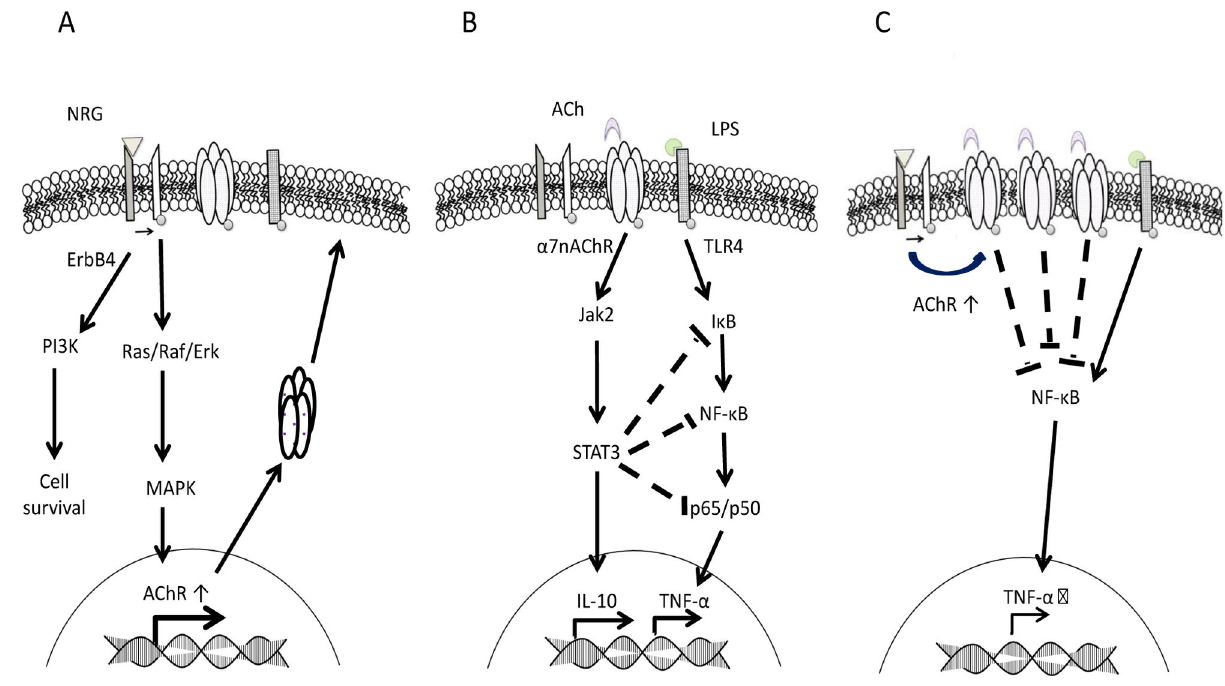
Figure 5. Proposed mechanism of NRGs neuroprotective action during inflammation. Here we propose a model where in NRG amplifies the cholinergic anti-inflammatory pathway mediated by ACh and α7 nAChR during an inflammatory response. In panel A, we describe the possible signaling pathway responsible for the increased expression of α7nAChRs observed in microglia when treated with NRG. NRG signaling through ErbB4 activates Ras/Raf/ERK of the MAPK pathway which leads to cell survival, and in muscle has been shown to activate the N-box response elements associated with the transcription of AChRs. Also of importance to NRGs neuroprotective function is the activation of the p85 subunit of PI3K pathway, its downstream effector PKB/Akt, and Jak/STAT pathways [16,51,52] (not shown); signaling mechanisms also involved in cell survival. In panel B, we describe the well established cholinergic anti-inflammatory pathway [modified from 38]. In response to inflammatory mediators, activation of the α7nAChR by its ligand ACh inhibits the synthesis of TNF-α by preventing the nuclear translocation of the p65 subunit of NF-κB. In addition, the activation of Jak2/STAT3 supports the synthesis of anti-inflammatory cytokine IL-10 and further attenuates TNF-α production by STAT3 action on IκK, NF-κB and p65. In panel C, we propose that in LPS-challenged microglia NRG acting in concert with ACh leads to increased reduction of TNF-α by inducing increased expression of α7nAChR and as such amplifying the cholinergic anti-inflammatory pathway by providing more receptors for ligand